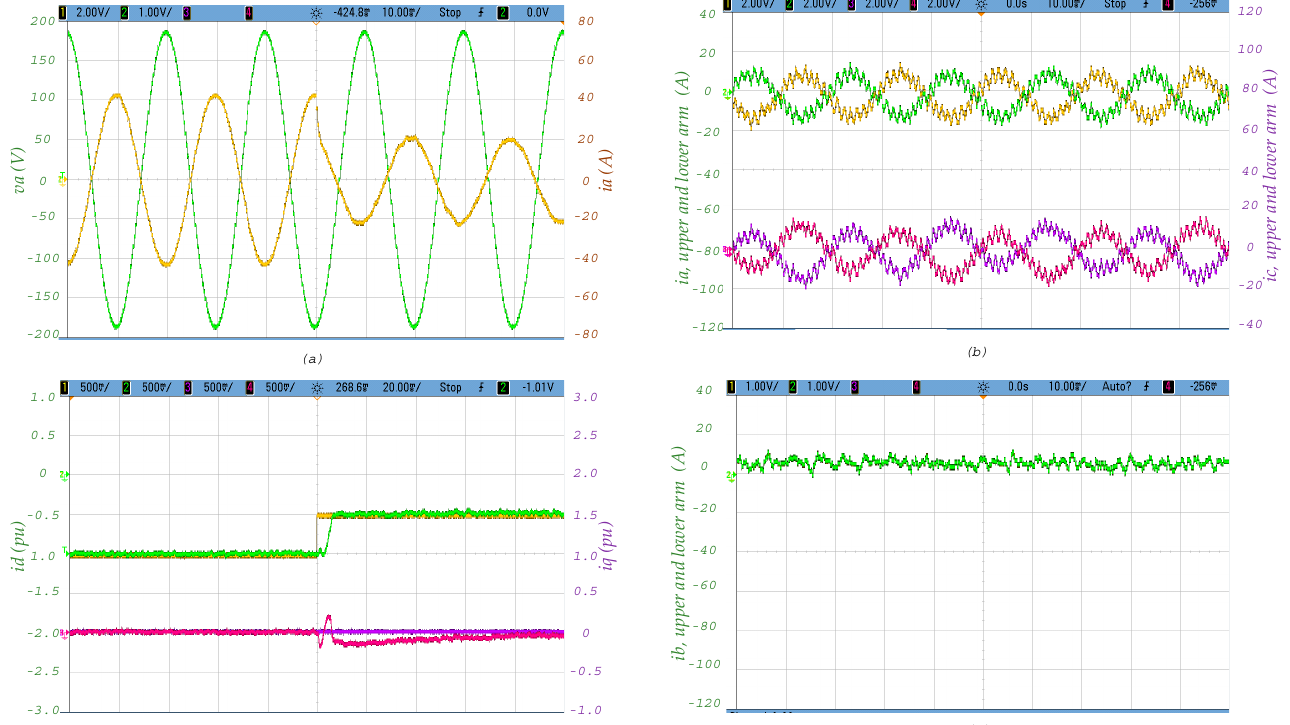
Figure 18. Real-time emulation of the MMC-EB charging system: ( a ) the grid voltage and the line current; ( b ) the arm currents in phases A and C; ( c ) active and reactive line current components; and ( d ) the arm currents in phase B.